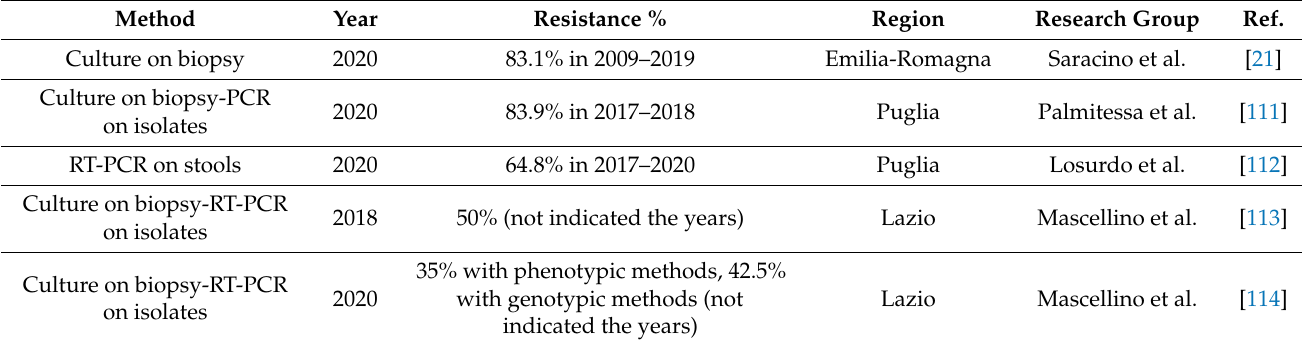
Table 5. Secondary clarithromycin resistance in Italy.